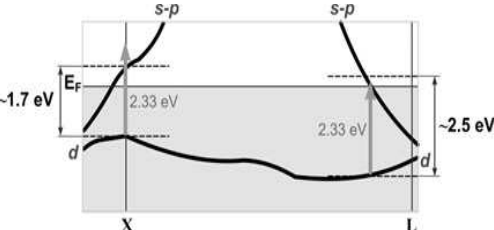
Figure 11. Energy level diagram explaining the mechanism of Au-nanocomposite optical